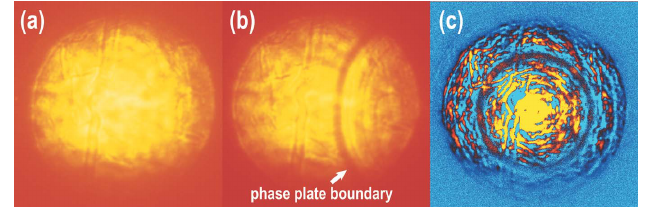
Figure 2 The phase plate alignment procedure. The phase plate is located between the CRLs and the microscope installed downstream from the focal spot position. ( a ) An image of a defocused X-ray beam without the phase plate. ( b ) The phase plate is moving in the field of view, approaching the central position from the right-hand side. ( c ) The phase plate is centered and the image is produced by subtracting the background, e.g. panel ( a ), from the image with the phase plate centered. In the final steps of alignment and with the sharp edge placed at the position of optimal focus, we make a small displacement of the phase plate perpendicular to the incident beam and scan the sharp edge in order to achieve the best beam shape.